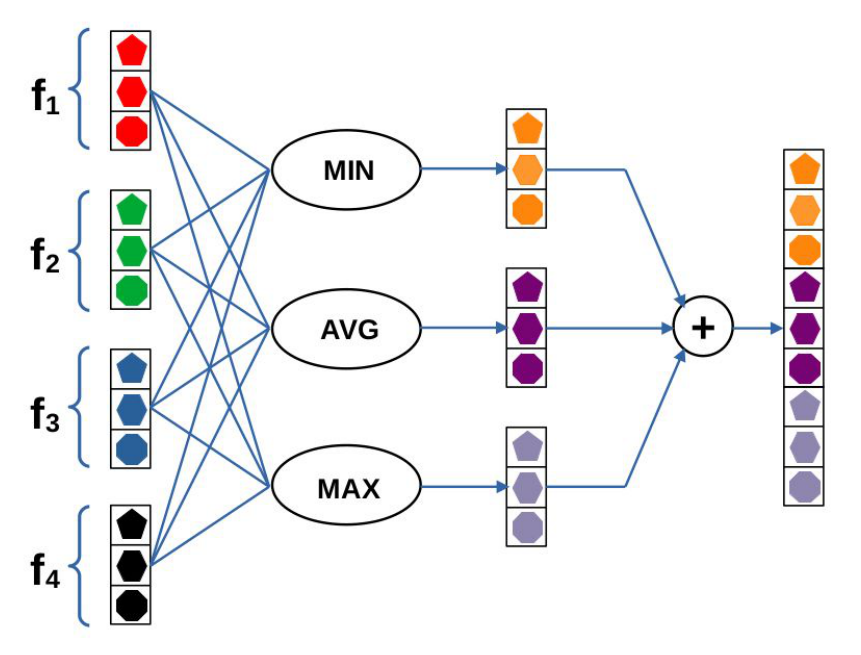
Figure 2. Illustration for orderless pooling of feature vectors. The core components of this structure correspond to a set of statistical functions, i.e., minimum, average, and maximum. Each function is applied to the set of input feature vectors and the outputs of the functions are concatenated. The figure is best viewed in